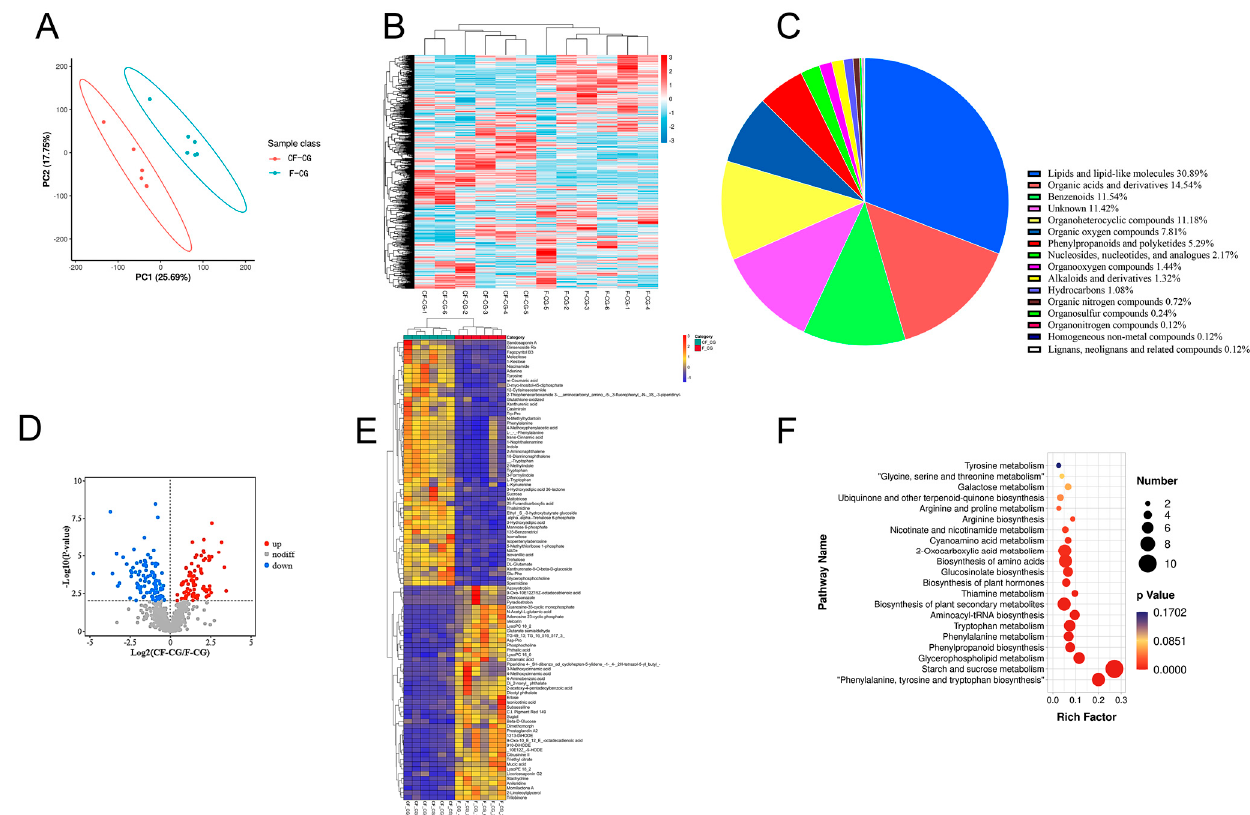
Figure 4. Basic metabolite information of F-CG and CF-CG based on non-targeted metabolomics. ( A ): Principal component analysis of the metabolites identified in F-CG and CF-CG. ( B ): Clustering analysis of F-CG and CF-CG samples. ( C ): A pie chart depicting the class of metabolites identified. ( D ): Volcano map showing differentially accumulated metabolites (DAMs) up-regulated, down- regulated or unchanged between F-CG and CF-CG samples. ( E ): Differential expression of DAMS between F-CG and CF-CG. ( F ): KEGG enrichment analysis of DAMs between F-CG and CF-CG.